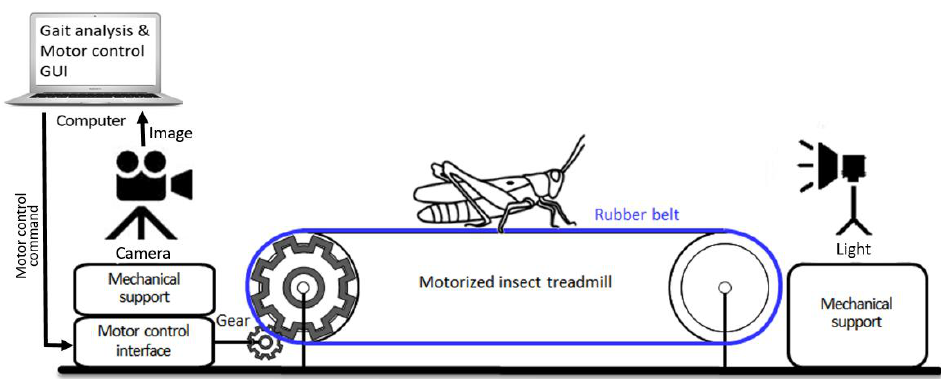
Figure 1. Overall experimental setup of the motorized insect treadmill, which is capable of changing belt speed, with optical recording system.